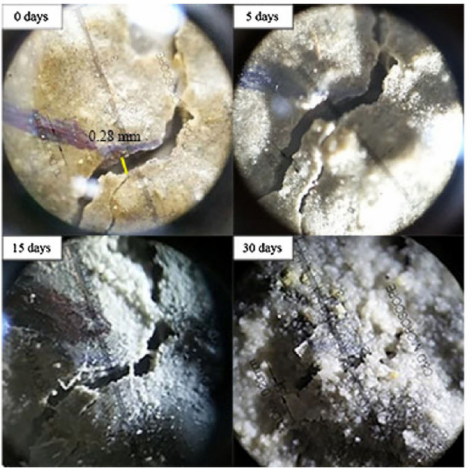
Figure 8. Development of crack closing in the bacterial concrete after 30 days based on microscopic image. Reproduced with permission from [29]. Copyright 2020,